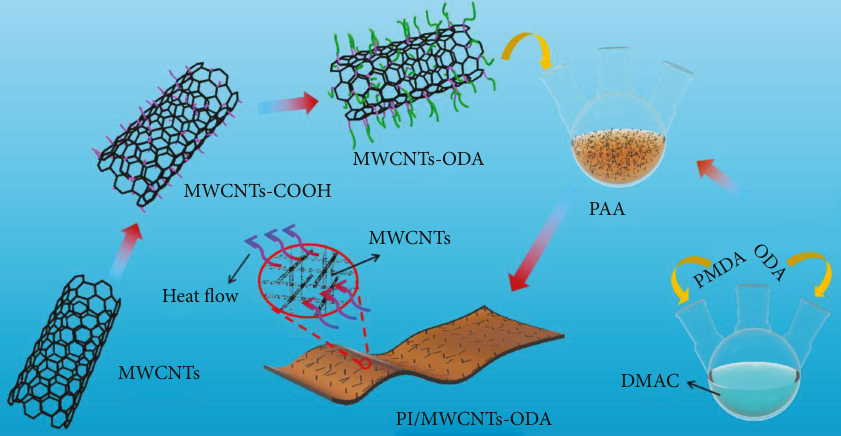
Scheme 2: The preparation process of MWCNTs-ODA/PI composite fi